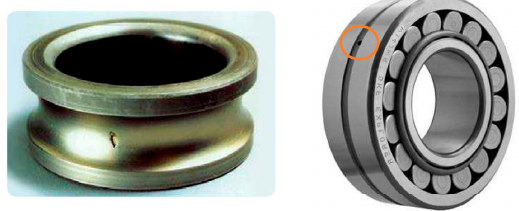
Figure 3. Bearing damage, inner ring ( left ) and outer ring ( right ) [38].